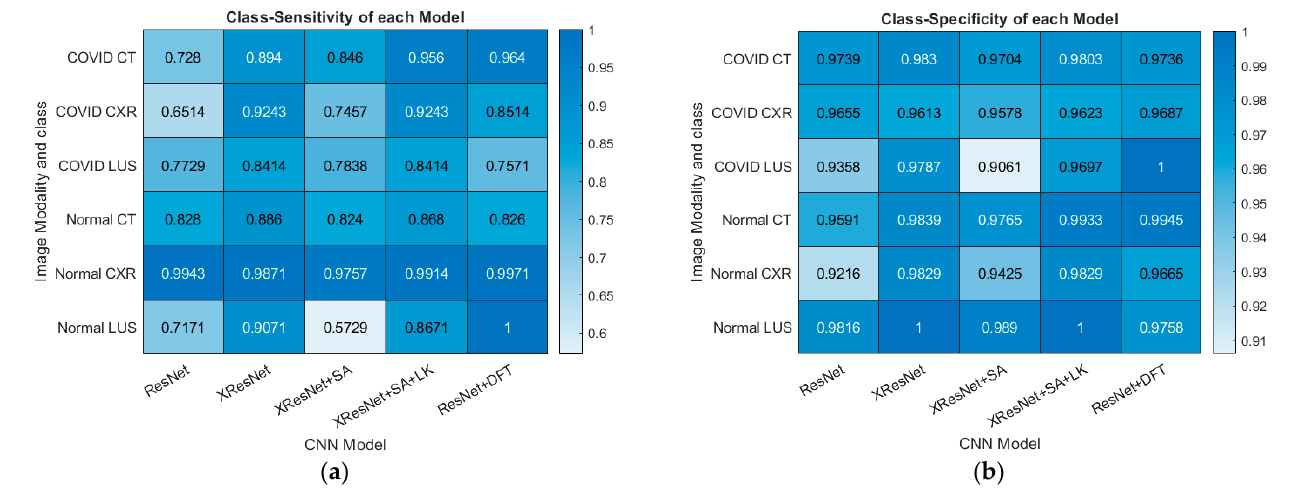
Figure 7. Performance Metrics Statistics on the Validation dataset. ( a ) Class-specific Sensitivity for each Model ( b ) Class-specific Specificity for each Model.